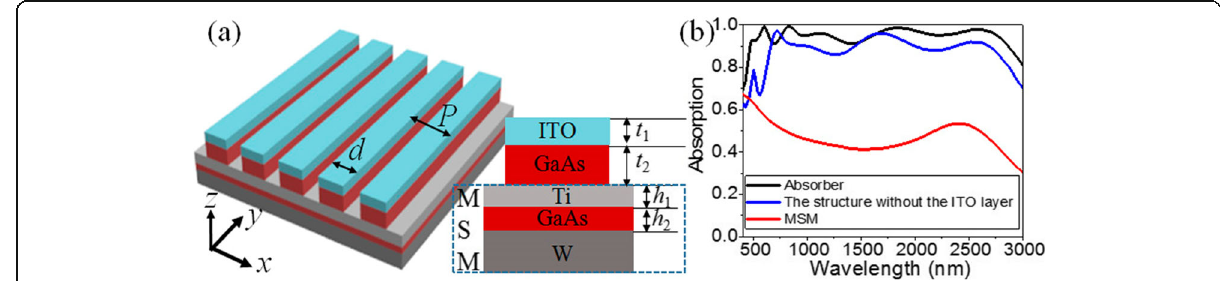
Fig. 1 a Schematic of the proposed solar absorber. b Absorption spectra of the solar absorber (black line), MSM stack structure (red line), and MSM structure coated with only GaAs nanoantennas (blue